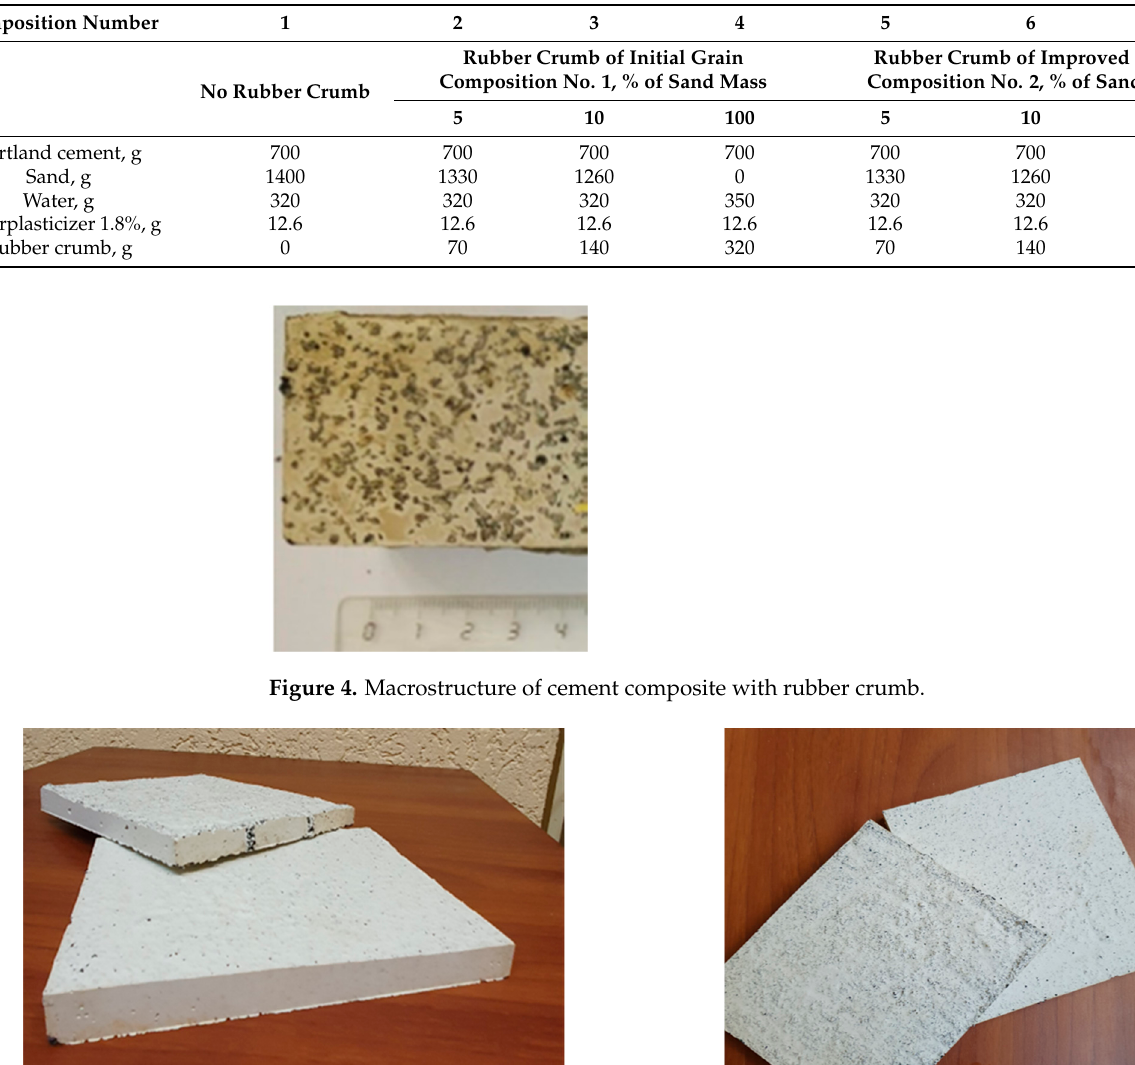
Table 2. Compositions of mortars based on Portland cement.